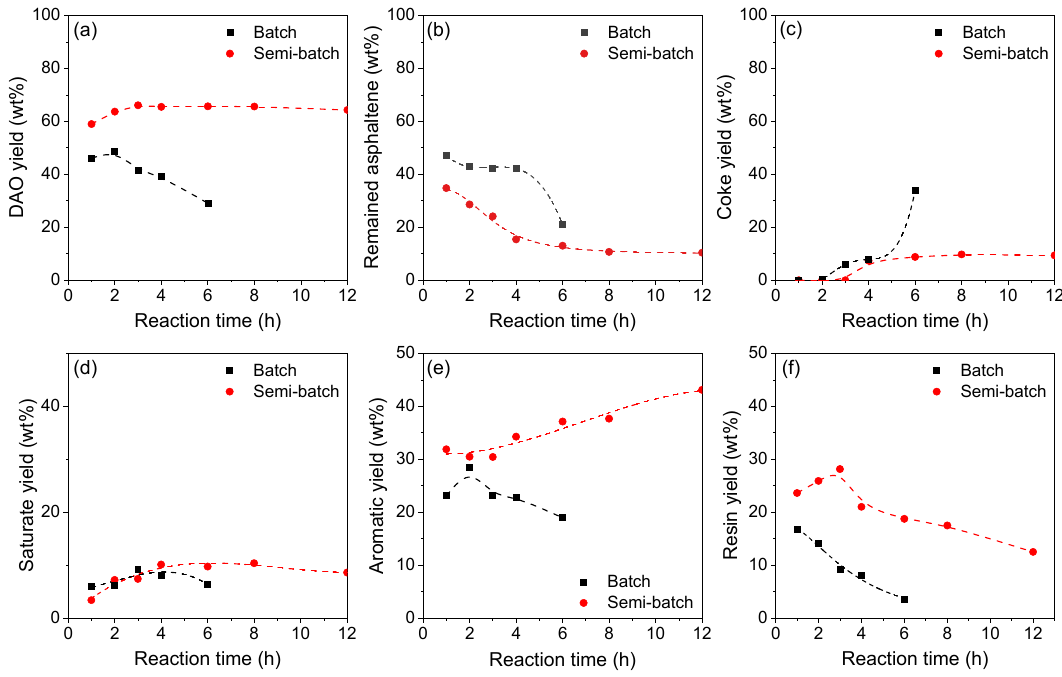
Figure 5. Yields for ( a ) DAO, ( b ) remaining asphaltenes, ( c ) coke, ( d ) saturates, ( e ) aromatics, and ( f ) resins in catalytic hydrocracking of C 5 -Asp using a batch and semi-batch system. Reaction conditions: T = 410 °C, P H2 = 80 bar at 80 °C (batch) or 110 bar at 410 °C (semi-batch), and 1000 wppm of Mo from Mo-octoate in catalytic hydrocracking.